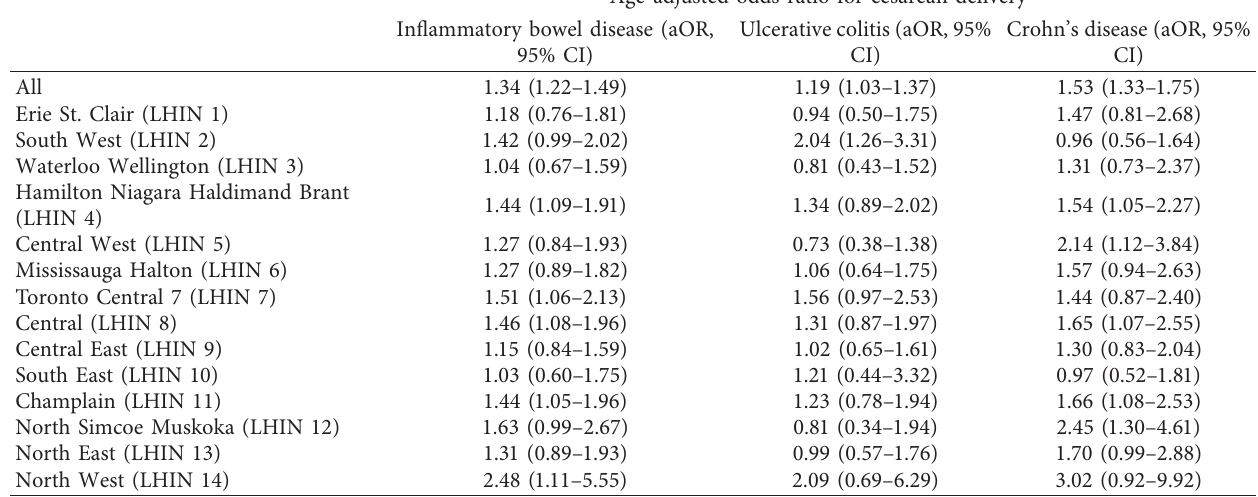
Table 5: Age-adjusted odds ratio for Cesarean delivery for women with inflammatory bowel disease, stratified by ulcerative colitis and Crohn’s